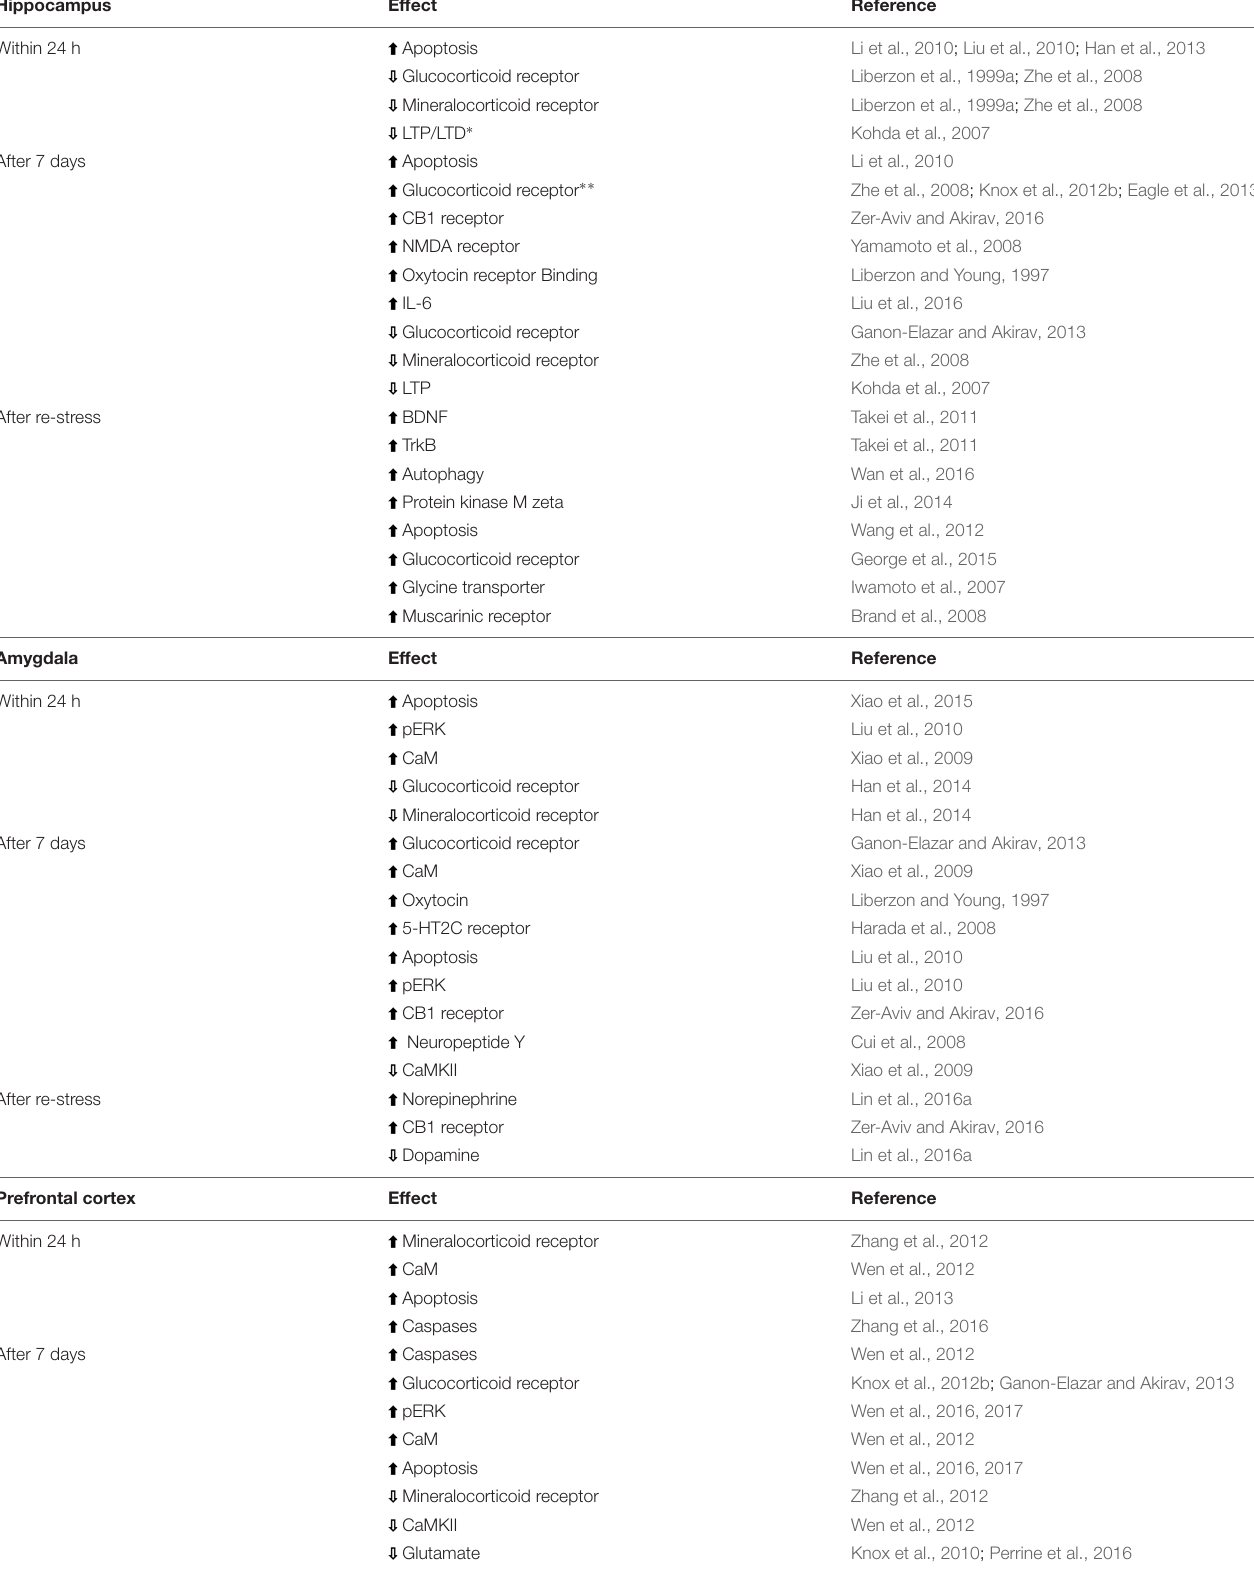
TABLE 1 | Cellular changes in three key areas controlling memory and emotionality after single prolonged stress (SPS) model of